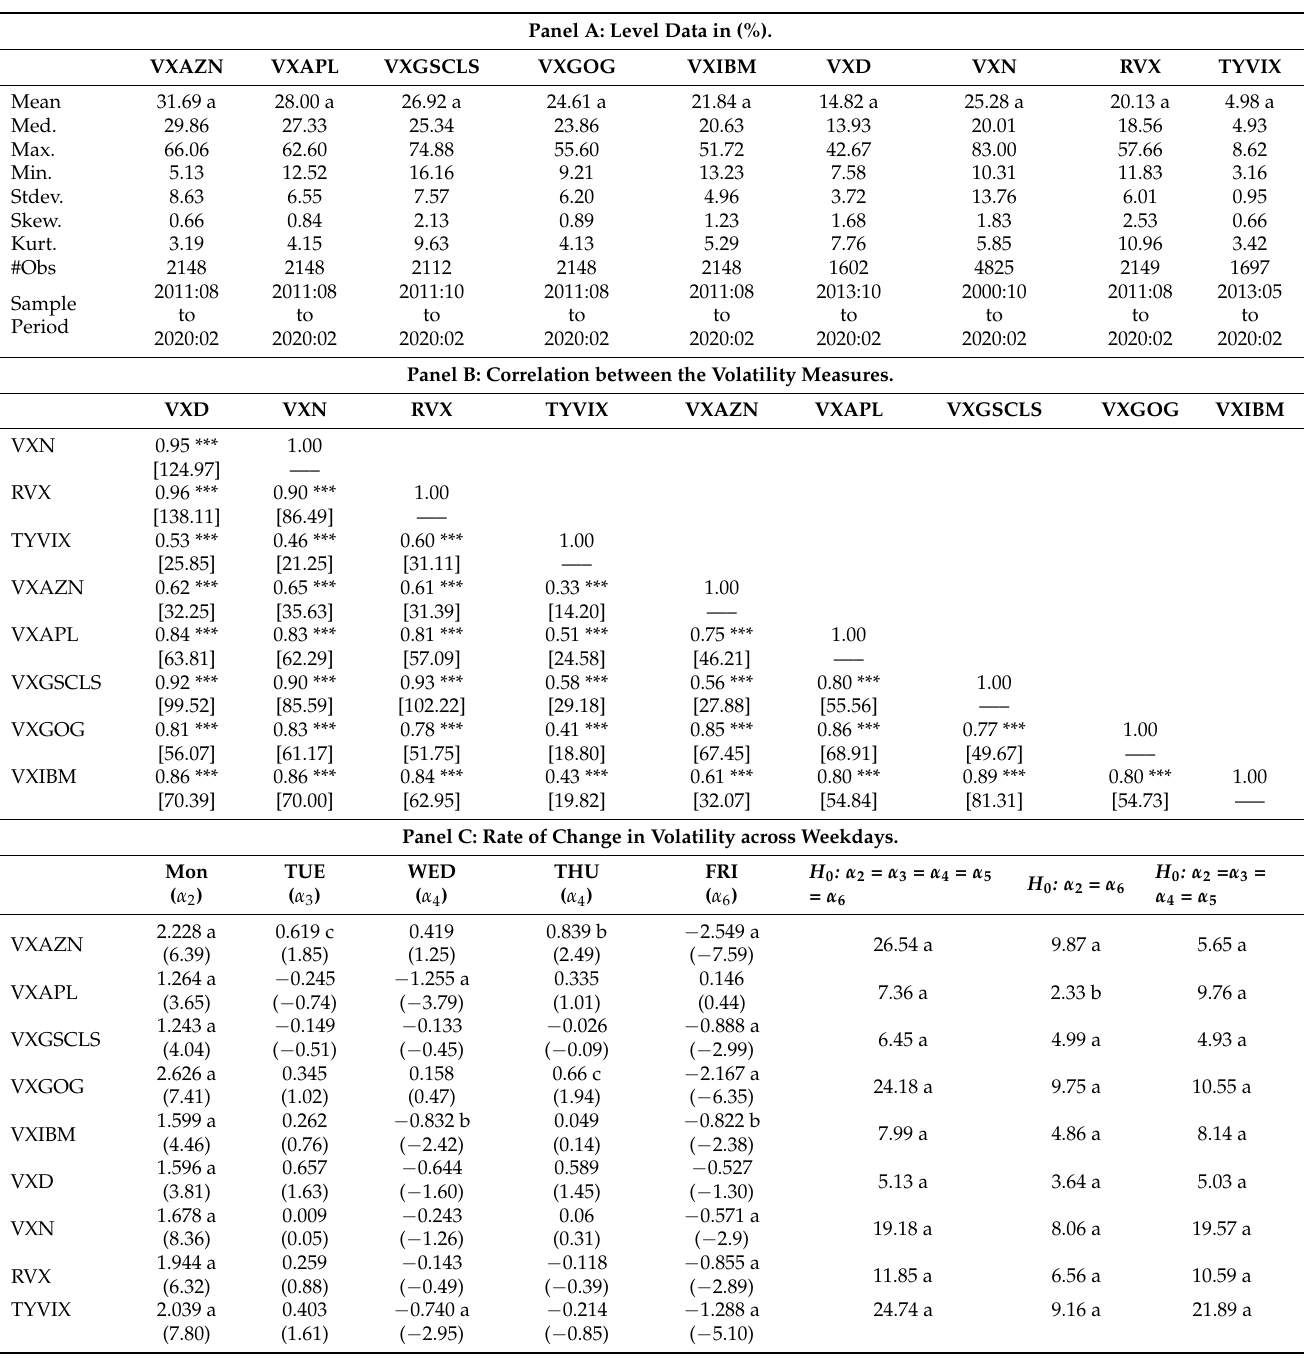
Table 2. Descriptive statistics. Panel A: Level Data in (%).